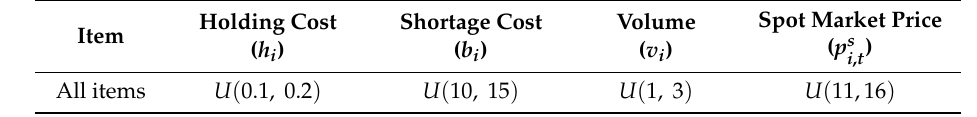
Table 3. Input parameters for items.